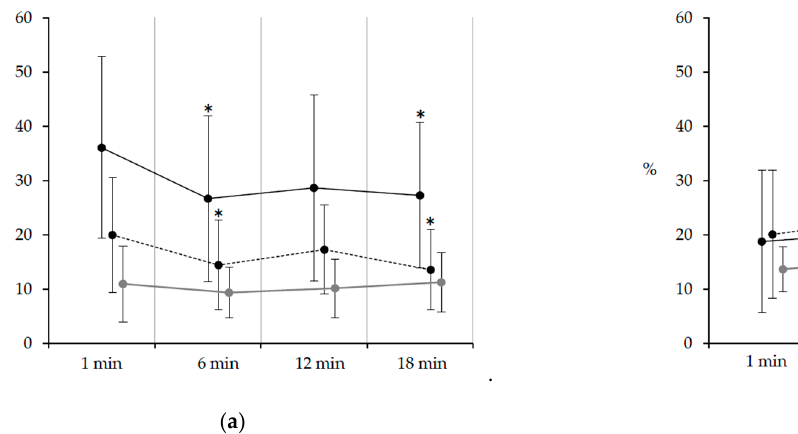
Figure 1. Temporal changes in electromyography amplitude during the extended walking test. Values are expressed as mean (standard deviation). ( a ) Tibialis anterior during the pre-swing phase; ( b ) rectus femoris during the single-support phase. The solid line represents the paretic side, the dotted line represents the nonparetic side, and the gray line represents healthy subjects. The EMG amplitude in the tibialis anterior during the pre-swing phase on the paretic side significantly decreased at 6 min and 18 min, and on the nonparetic side significantly decreased at 6 min and 18 min compared with that at 1 min. The amplitude in the rectus femoris during the single-support phase on the paretic side significantly increased at 18 min, and on the nonparetic side significantly increased at 18 min compared with that at 1 min.